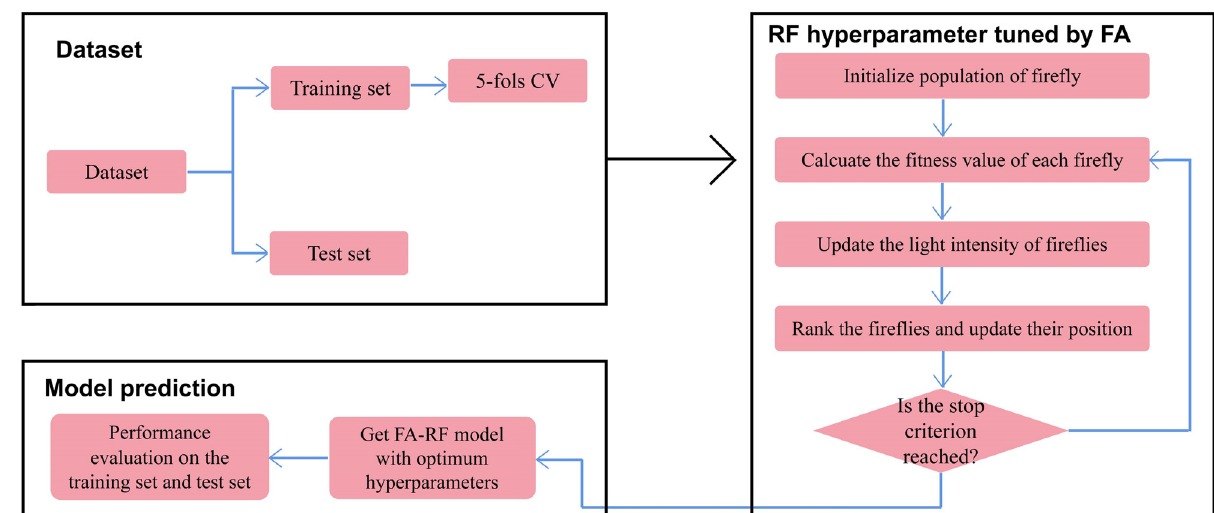
Figure 9: RF model training by 5 - fold CV and